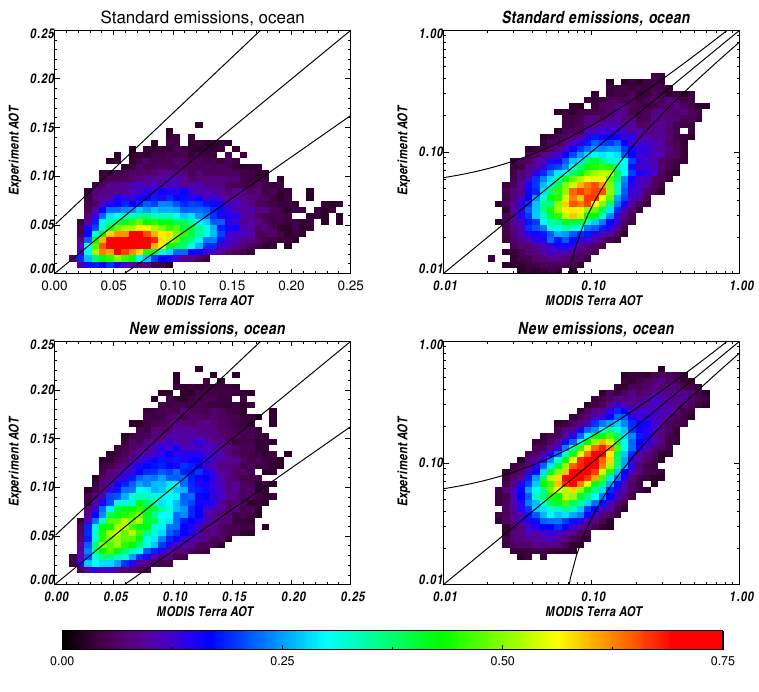
Figure 4. Distribution of 3-hourly co-located experiment and MODIS Terra AOT over ocean for the last three weeks of January 2009. The central black line represents y = x and the outer two black lines represent minimum MODIS AOT errors. The colour bar shows percentage of total